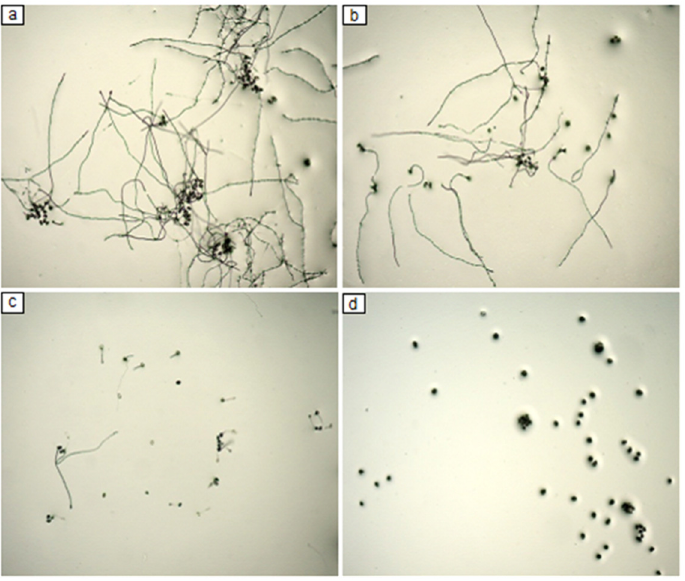
Figure 2. Spore germination of P. pachyrhizi in water agar plus with different concentrations of the semi-purified fraction F4A. ( a ) control, ( b ) 1 µg mL − 1 , ( c ) 10 µg mL − 1 and ( d ) 100 µg mL − 1 . semi-purified fraction F4A. ( a ) control, ( b ) 1 µ g mL − 1 , ( c ) 10 µ g mL − 1 and ( d ) 100 µ g mL − 1